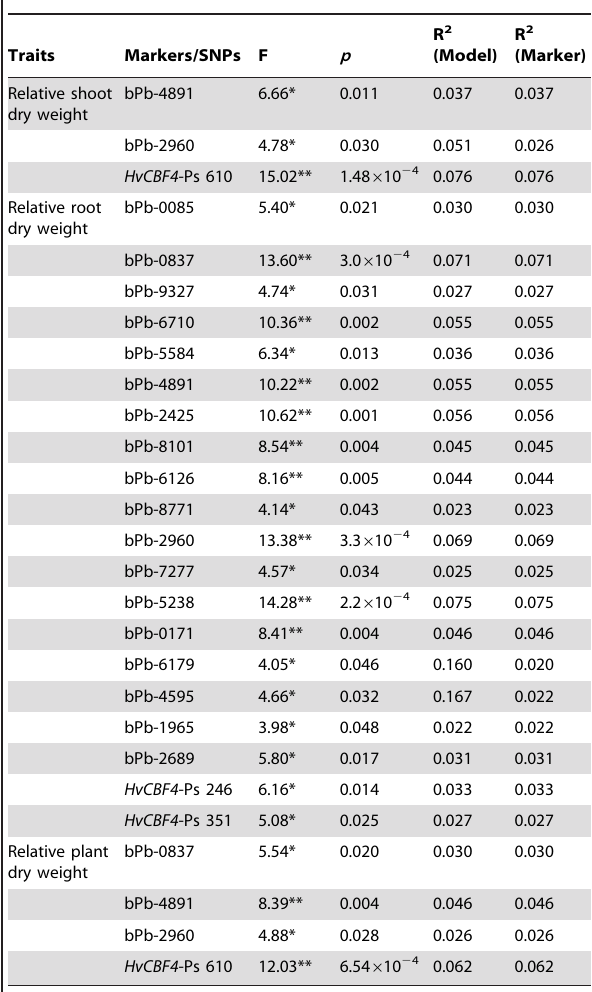
Table 2. The results of DArT markers on chromosome 5 and SNPs of HvCBF genes associated with relative dry weight of Tibetan barley.